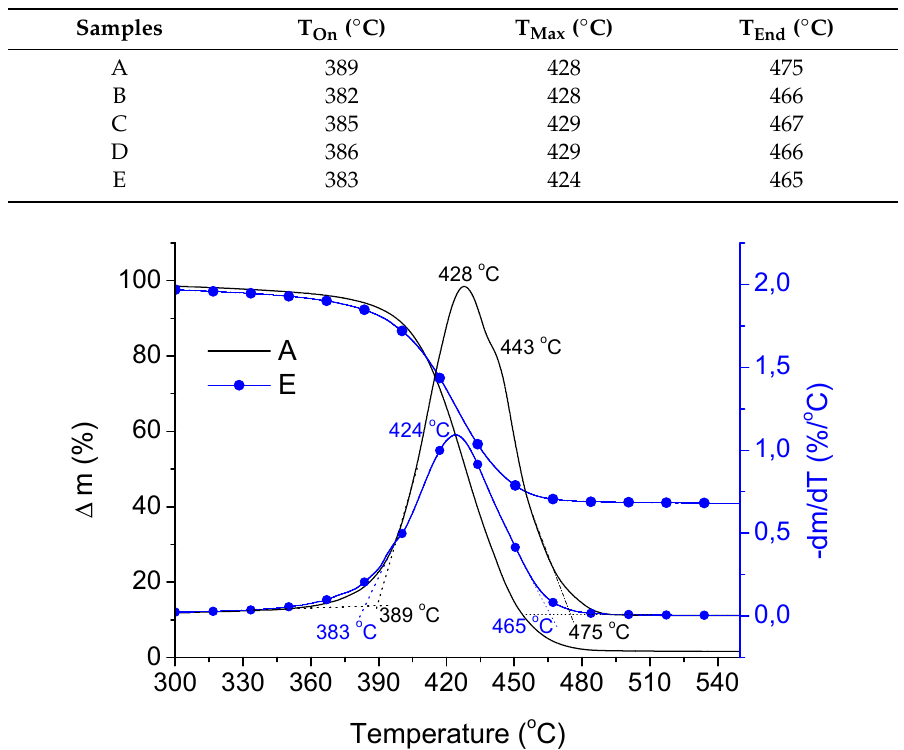
Figure 4. TG / DTG carves for A and E Figure 4. TG/DTG carves for A and E samples.